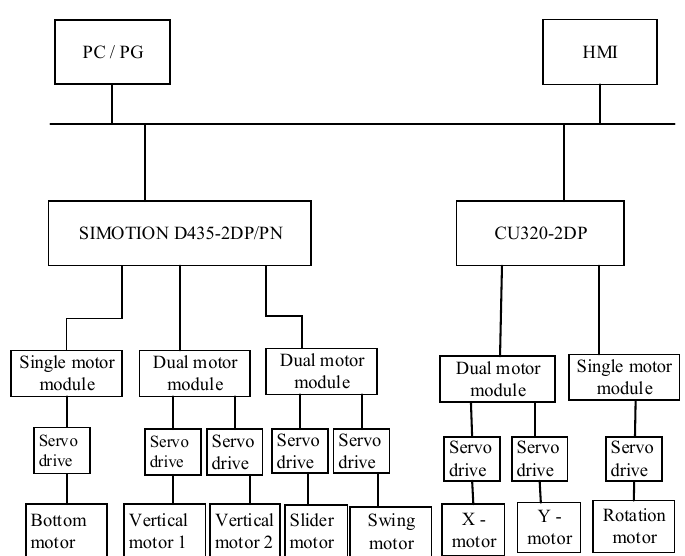
Figure 9. Control system flow chart. HMI—human–machine interface.